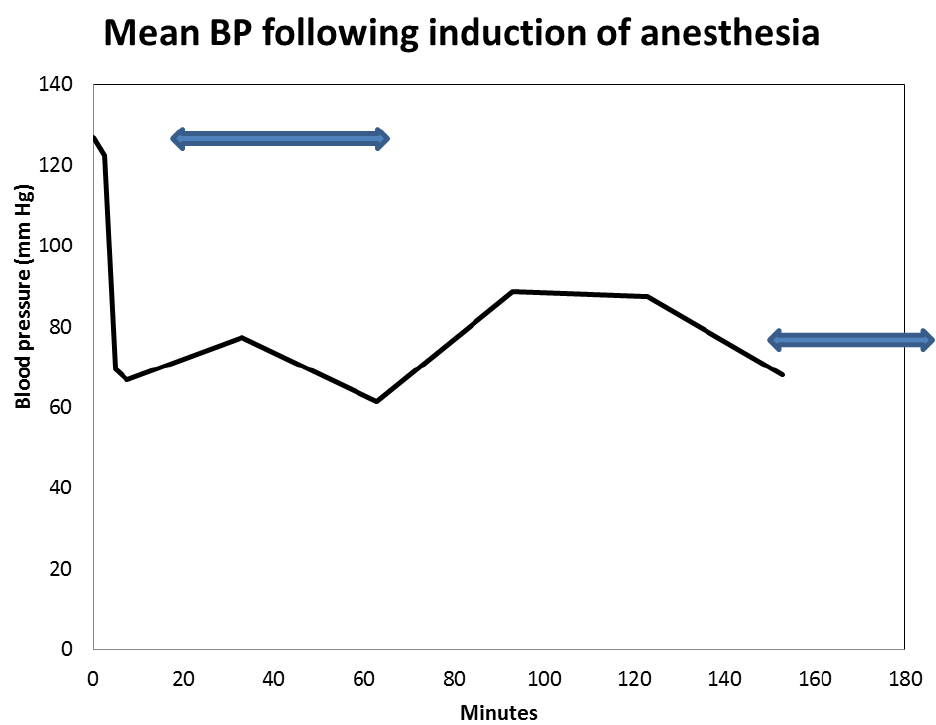
Figure 12. Intra-operative mean blood pressure translations after induction of anesthesia during elective ablation procedure for symptomatic atrial